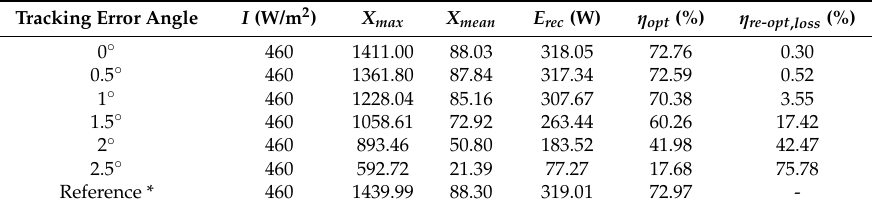
Table 3. Experimental optical characteristics of the fixed-focus Fresnel lens solar concentrator under different tracking error